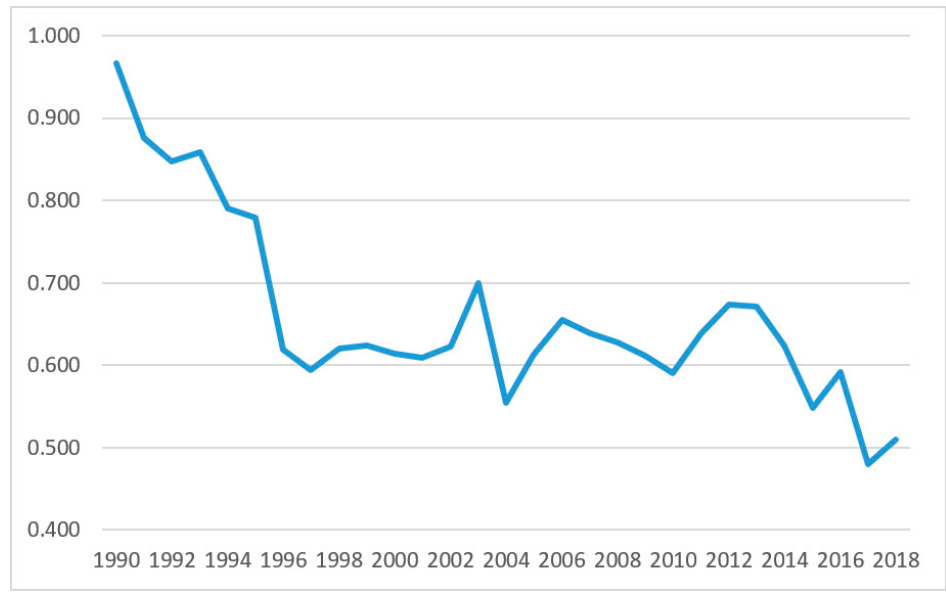
Figure 5. National emission factors for electricity consumption in Ukraine, tCO 2 /MWh [34].